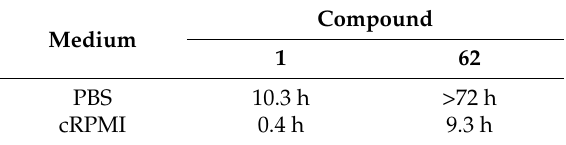
Table 12. Stability of quercetin-glutamic acid conjugate 62 compared to quercetin 1 .